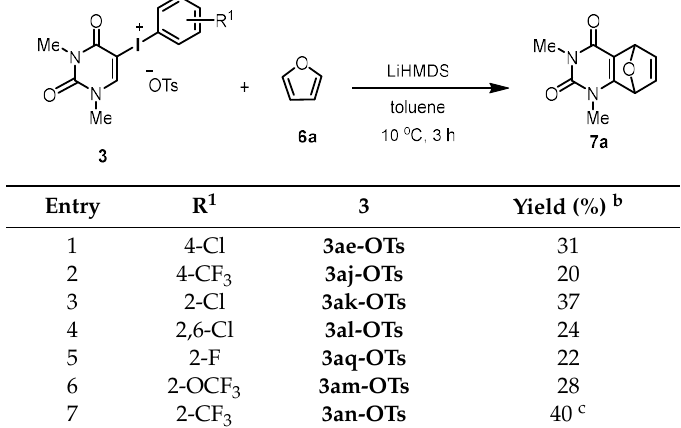
Table 3. Optimization of furan addition to uracil ring with base activation of iodonium(III) salt 3 a . LiHMDS, lithium